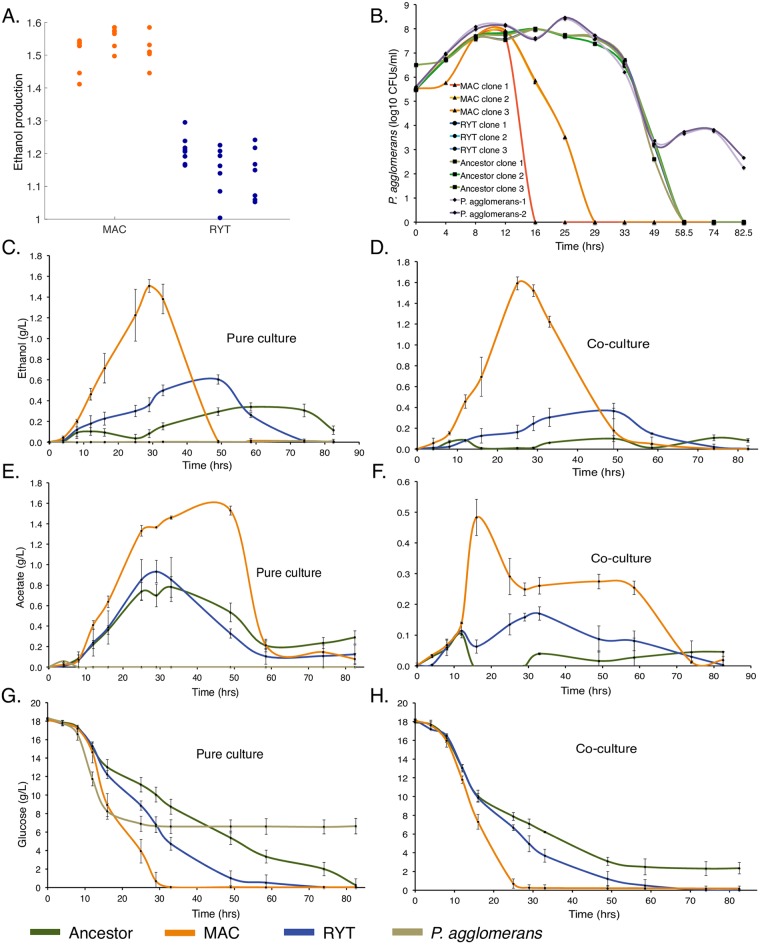
MAC and RYT treatments evolved different metabolite production and consumption profiles.(A) Ratio (fold change) of ethanol yields of clones selected from MAC and RYT with respect to the ancestor is presented here. A fold change more than 1 indicates ethanol yield of ancestor is lower than MAC or RYT strain being compared with. The relative ethanol yield of MAC is significantly greater than RYT and ancestor strains (Mann-Whitney U, p < 10−4). The fermentative yeast S.cerevisiae CEN.PK113-7D (0.38g/L) [37] has 1.83 fold higher ethanol yield than the L. kluyveri ancestor (0.207g/L). (B) Time course of the numbers of P. agglomerans bacteria during co-culture with MAC (Triangles), RYT (Bullets) and ancestral strains (Squares), the time course of duplicate clones of P. agglomerans (Diamonds) in absence of yeasts as control (MAC vs RYT and ancestor Mann-Whitney U, p < 0.01). The decrease in bacteria can be attributed to reduction in carbon source. Ethanol (C, D) and acetate (E, F) production in MAC pure and co-cultures was significantly greater than RYT and ancestor strains (Mann-Whitney U, p < 0.01) and the peak of ethanol production in MAC strains coincides with the time point at which P. agglomerans was decimated. Glucose (G, H) was consumed by MAC at half the time that of RYT and ancestor strains in pure and co-cultures (Mann-Whitney U, p < 0.01). Error bars are one standard deviation and ancestor (green), RYT (blue), MAC (orange) and bacteria (P. agglomerans) (olive).